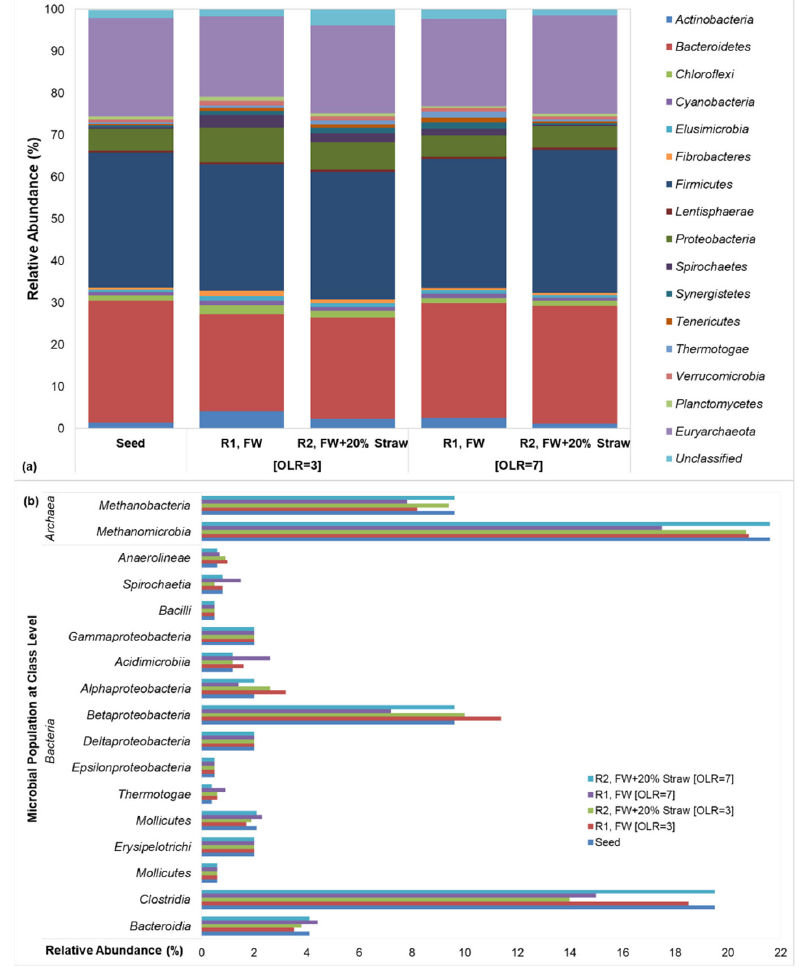
Figure 3. Relative abundance of microbial communities at ( a ) phylum level ( b ) class level at the end of Period 2 and Period 3 (target OLRs from FW were 3.0 and 7.0 gVS/L/d, respectively).